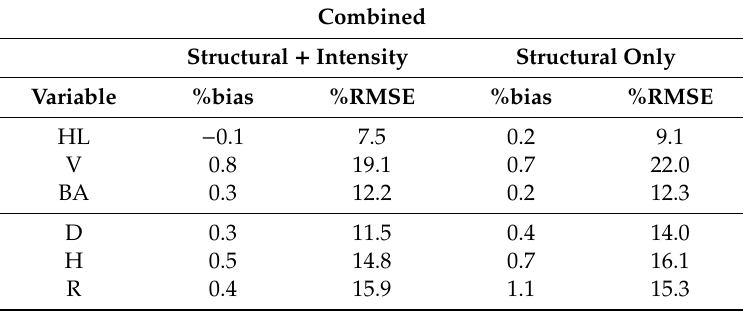
Table 9. %RMSE and %bias for structural only and combination of structure and intensity models derived from the all M-ALS wavelengths